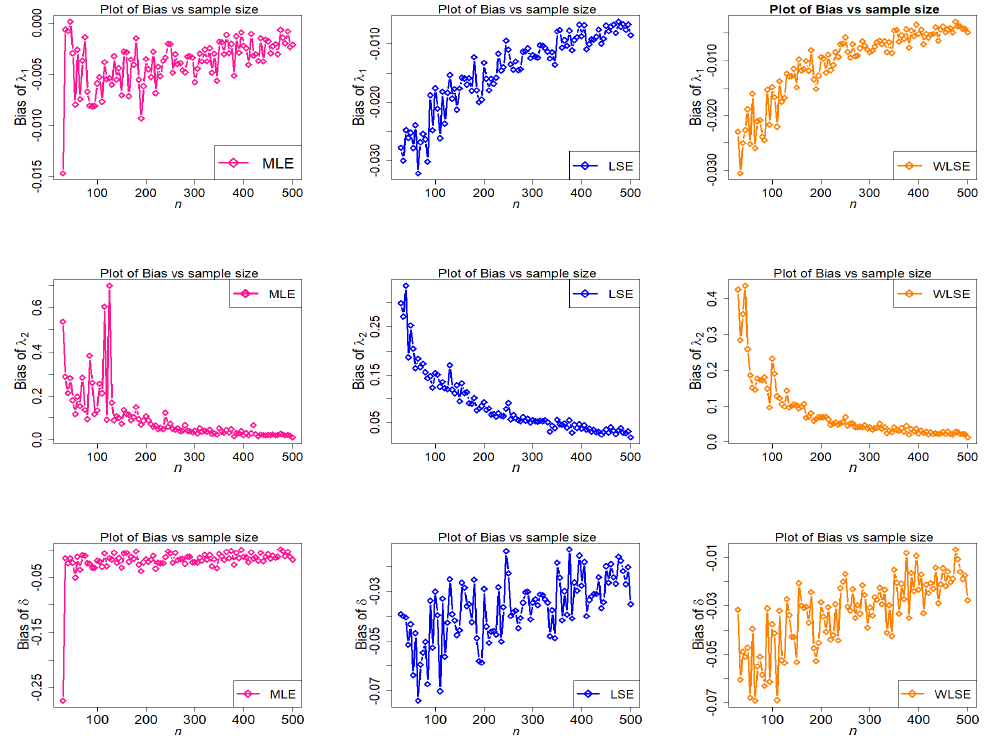
Figure 11. Behavior of bias of estimators with different methods under parametric set II against n Fig. 11. Behaviour of bias of estimators with di⁄erent methods under parametric set II against n .